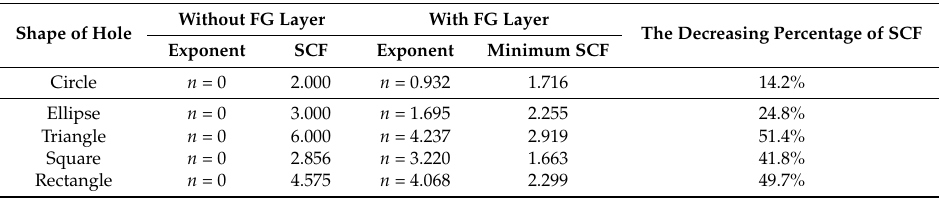
Table 1. The comparison of the stress concentration factor (SCF) for two different cases (with and without functionally graded (FG) layer).